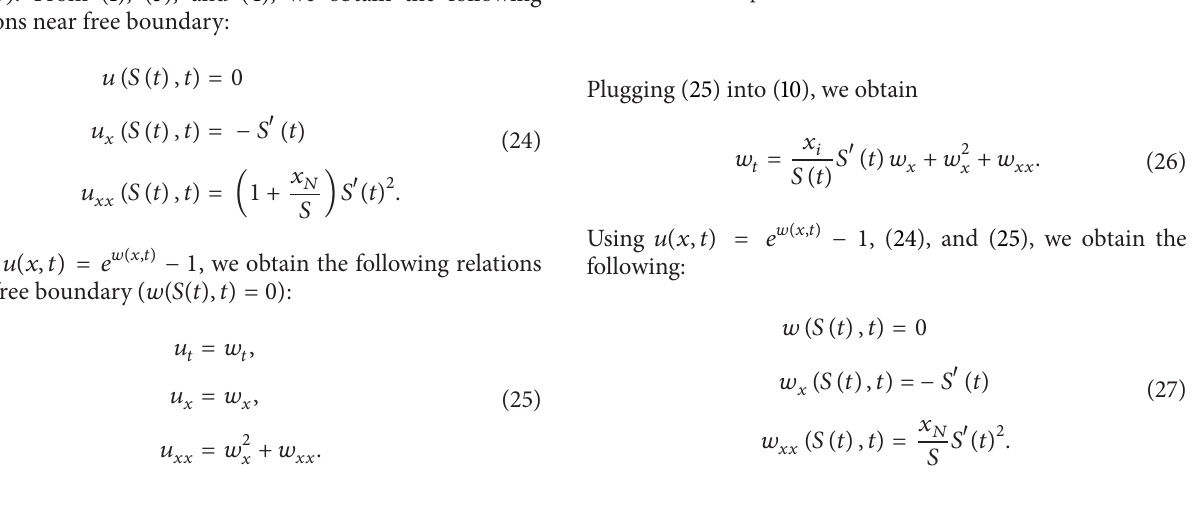
Figure 3: Comparison of RMSE and runtime in the